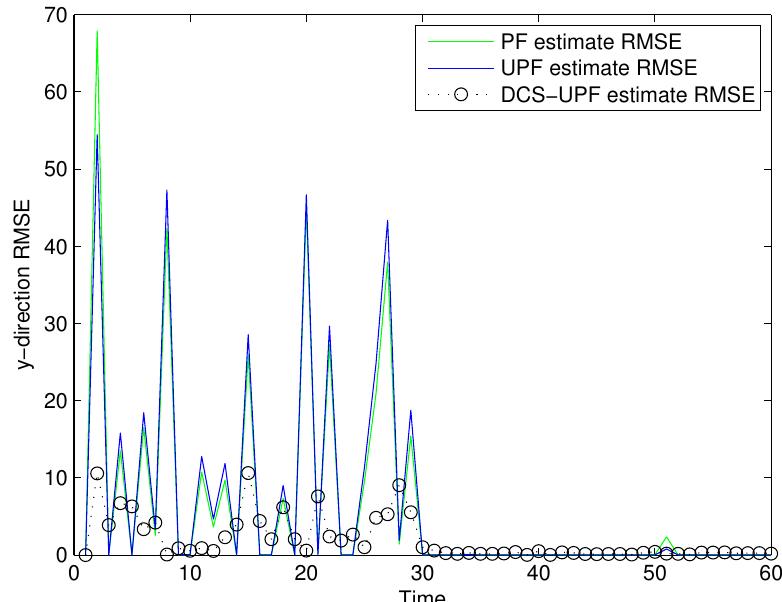
Figure 6. The tracking errors of three filters in